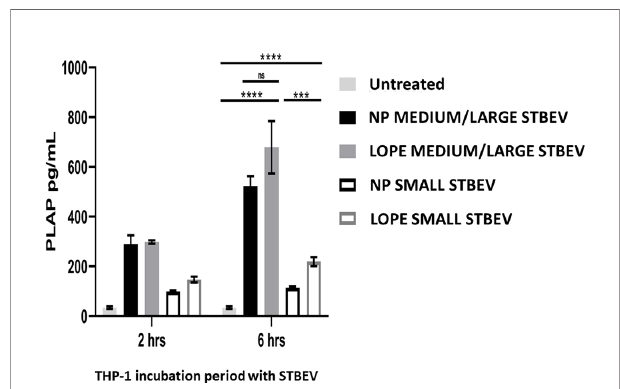
FIGURE 6 | ELISA using STB speci fi c marker, PLAP, on THP-1 macrophages treated with STBEVs derived from NP and PE placentae at 2 and 6 hours incubation. THP-1 cells do not innately express PLAP while STBEVs do. The presence of detectable PLAP in treated THP-1 cells indicate internalisation or/and fusion. Quanti fi cation analysis of NP and PE medium/ large STBEVs and small STBEVs expressing PLAP marker internalised by